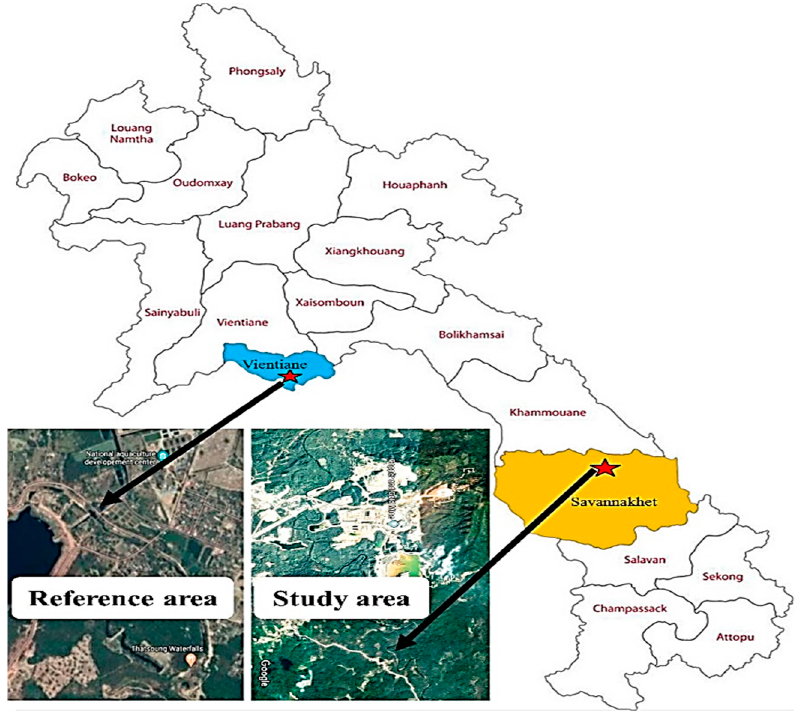
Figure 1. Geographical maps of the Nam Souang river as the reference area ( Left ) and the Nam Kok river near the Sepon gold-copper mine as the study area ( Right ).